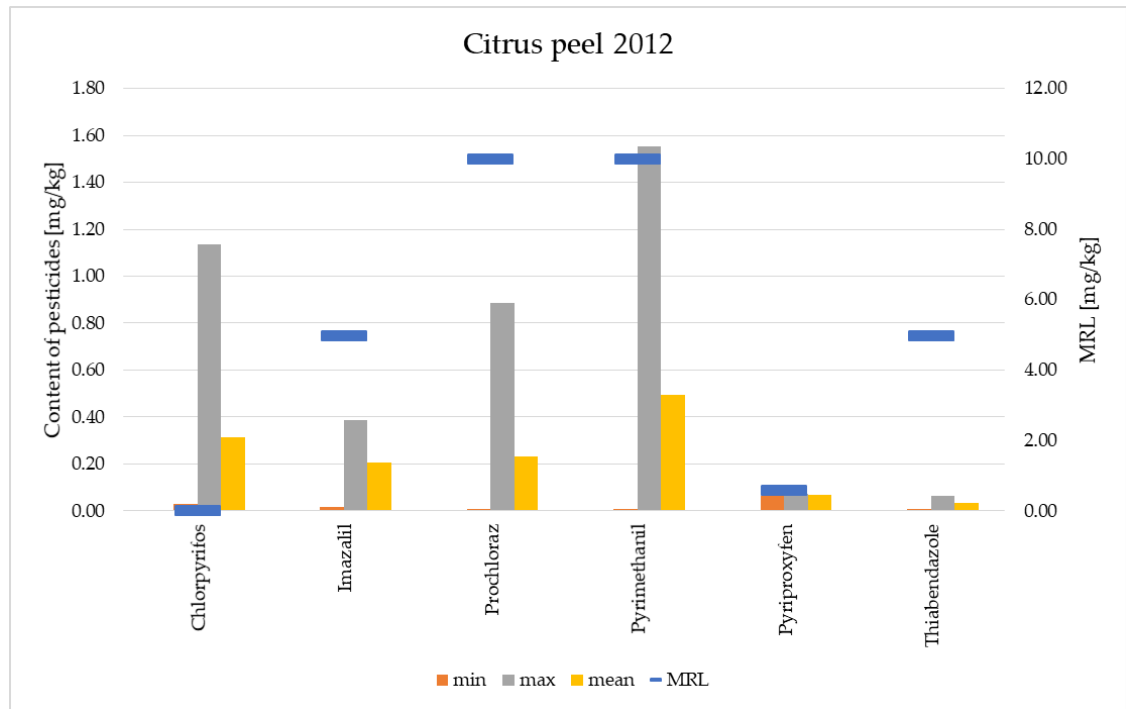
Figure 13. Content of pesticides in peels of citrus fruits from the harvest of 2012.